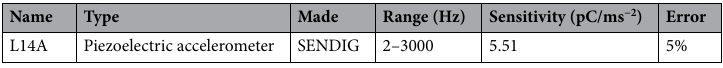
Table 5. Parameters of the L14A sensor.